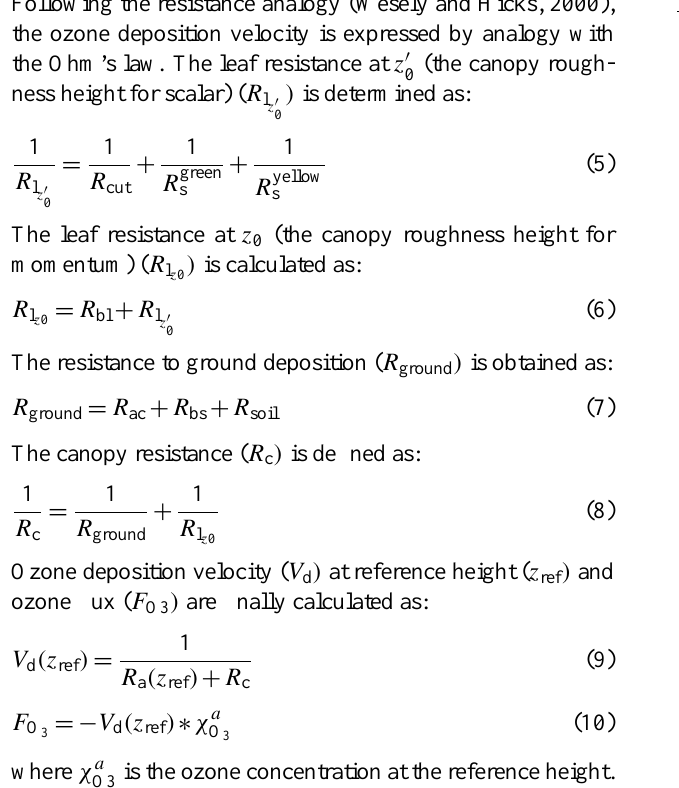
is the leaf temper- 0